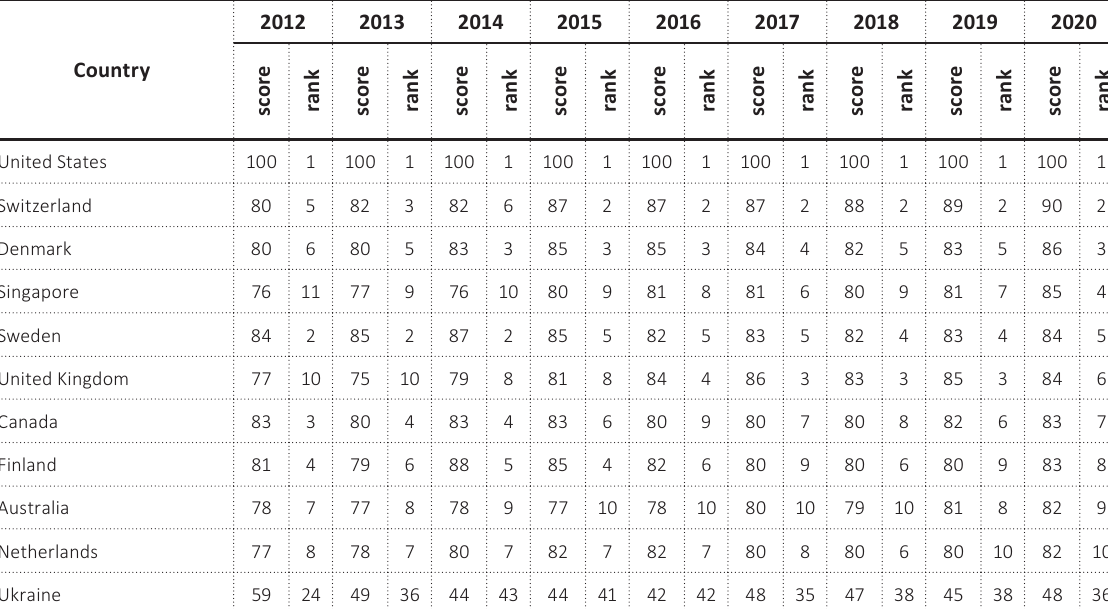
Table 1. Countries with the highest level of higher education competitiveness in 2012–2020